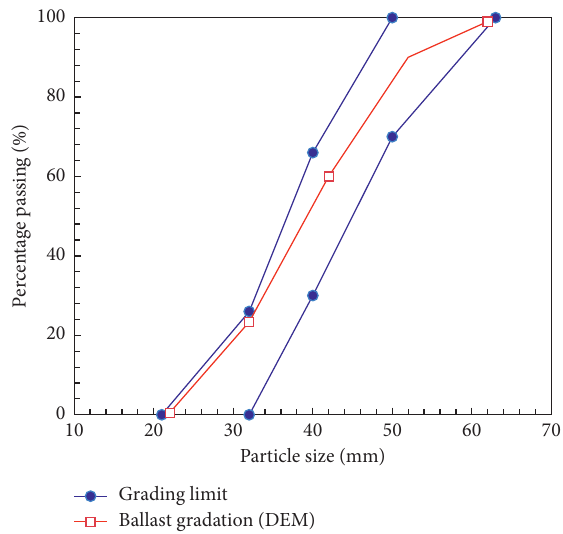
Figure 2: Particle sizes and gradation of